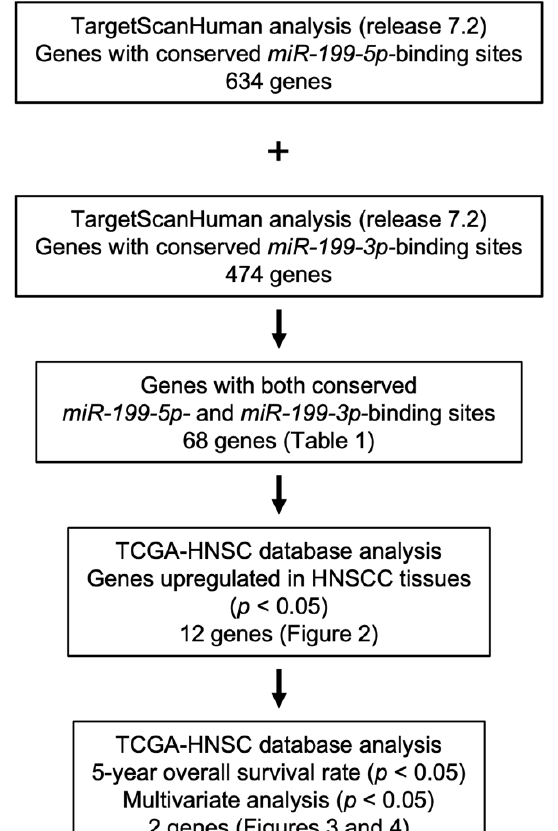
Figure 1. Flowchart of the strategy used to identify candidate miR-199-5p and miR-199-3p target genes in HNSCC cells . Table 1. miR-199-5p/3p common target genes.